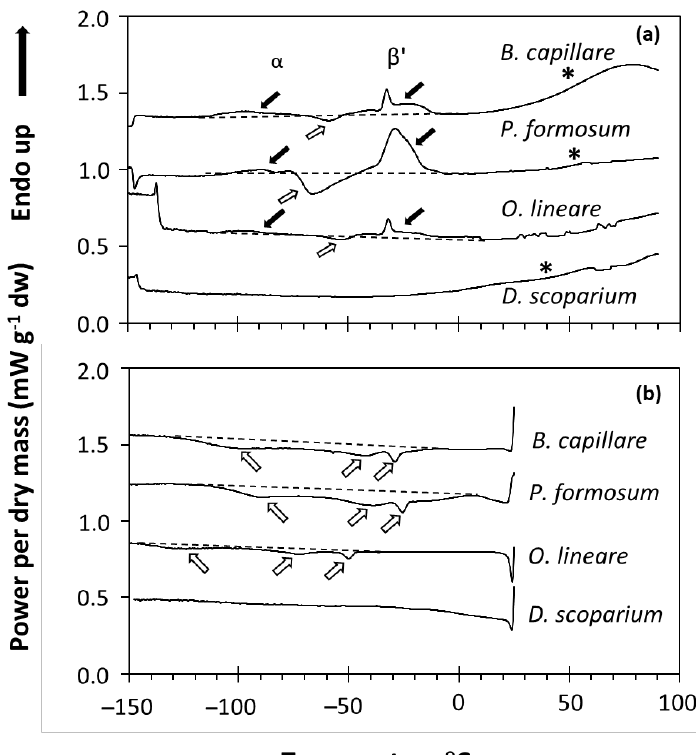
Figure 1. DSC melting ( a ) and cooling ( b ) scans of four bryophyte species ( Bryum capillare acc. 2, Polytrichum formosum acc. 2, Orthodontium lineare acc. 3, Dicranum scoparium acc. 4). Black arrows indicate lipid melting transitions, usually occurring with two events in the melting scans ( a ): one around − 80 or − 90 ◦ C (related to α crystals [46]) and one around − 30 ◦ C (related to β ’ crystals [46]). White arrows indicate lipid crystallization transitions, usually occurring with three broad events around − 90, − 50 and − 25 ◦ C in the cooling scans ( b ), but also as a lipid recrystallization event around − 60 or − 70 ◦ C in the warming scans ( a ). A dashed line was added to indicate the baseline of the scan considered. Asterisks indicate the broad second-order transition that marks the glass transition.